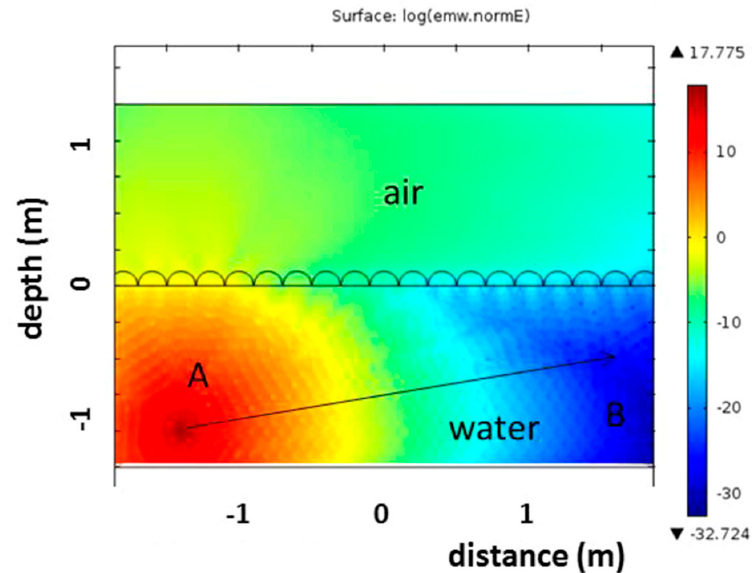
Figure 6. Numerical simulations of radio field distribution near the air/seawater interface, which is produced by a point source located near the sea surface. At large distances from a SEW antenna, the field is dominated by the SEW contribution. These simulations were performed using COMSOL Multiphysics solver.